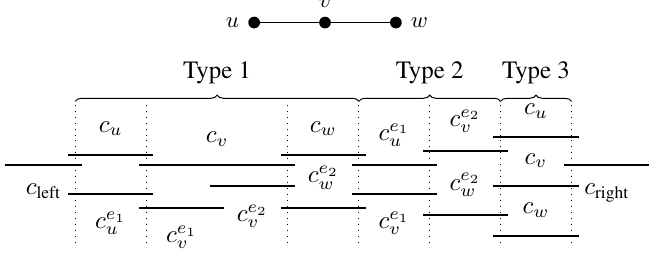
Fig. 1: A graph, and the set of intervals obtained by applying the reduction used in the proof of Theorem 2.2 when k = 2